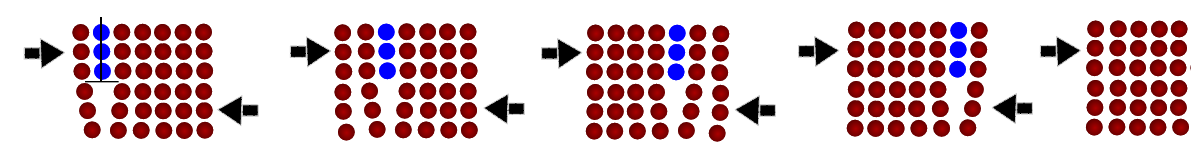
Figure 3. Progressive movement of a dislocation resulting in shear plastic